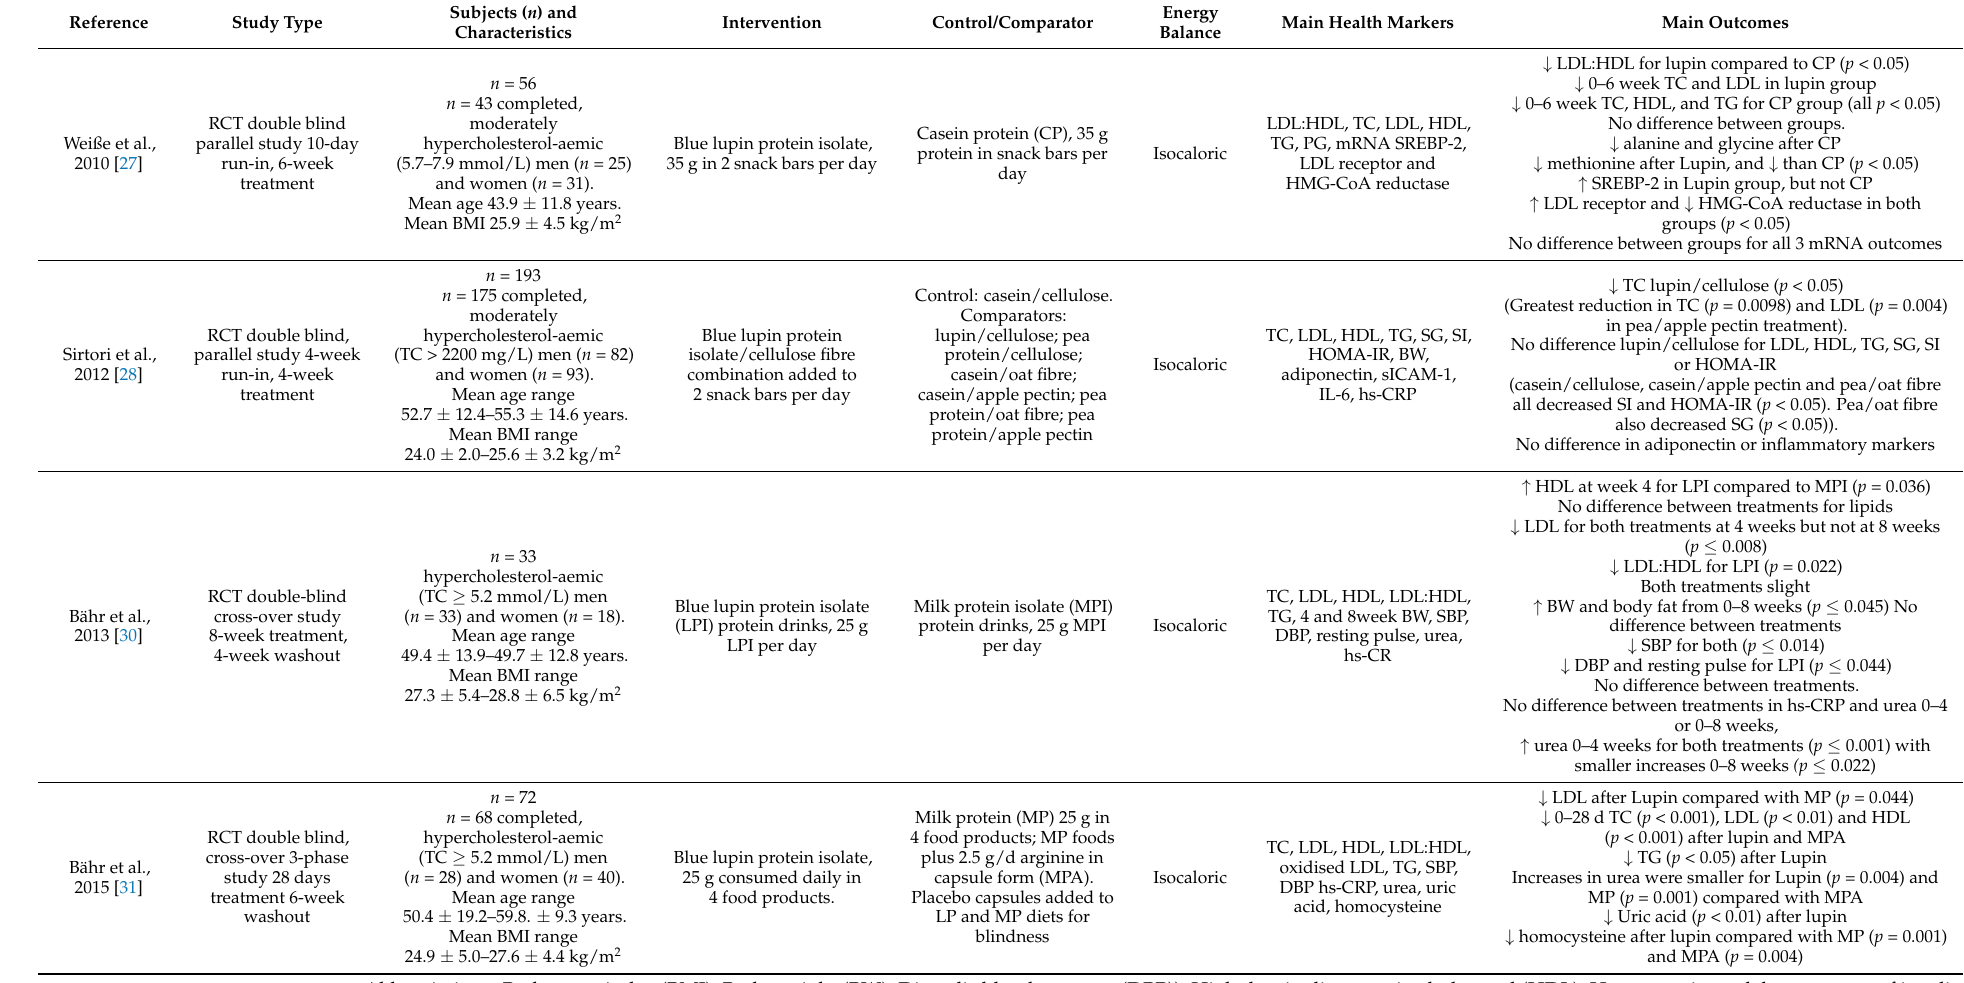
Table 3. Characteristics and major outcomes of studies examining lupin protein consumption and health